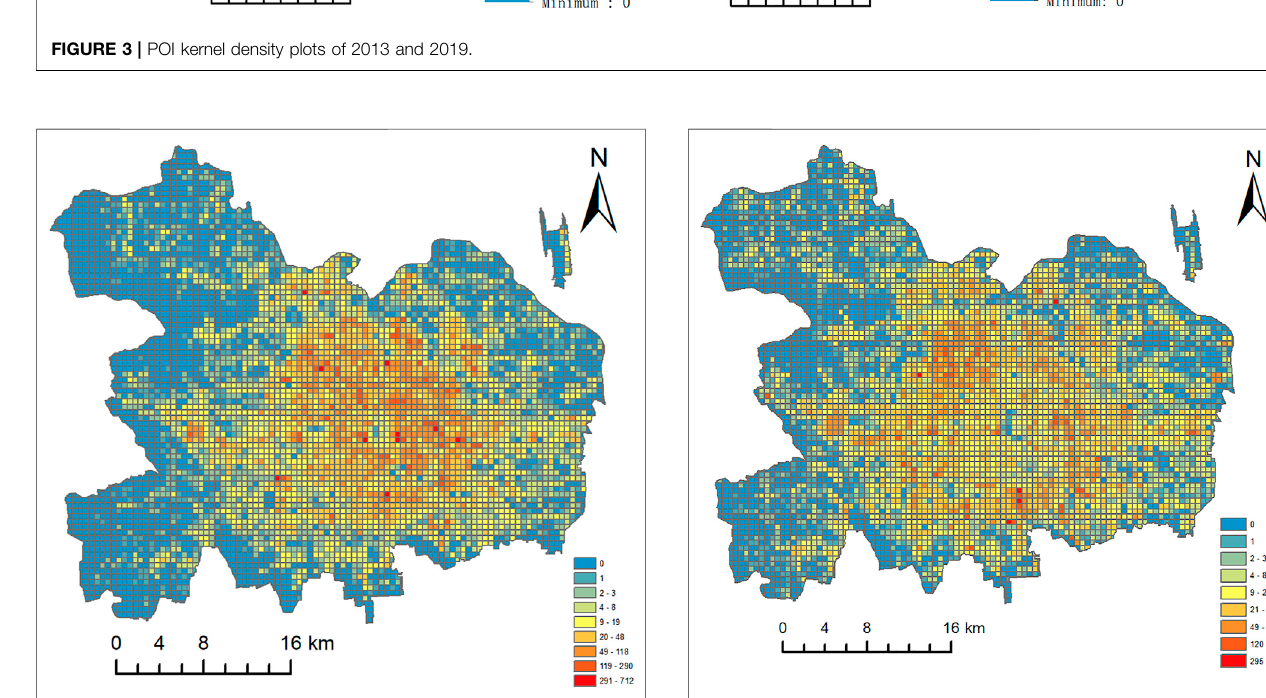
FIGURE 5 | POI content in fi shing nets in